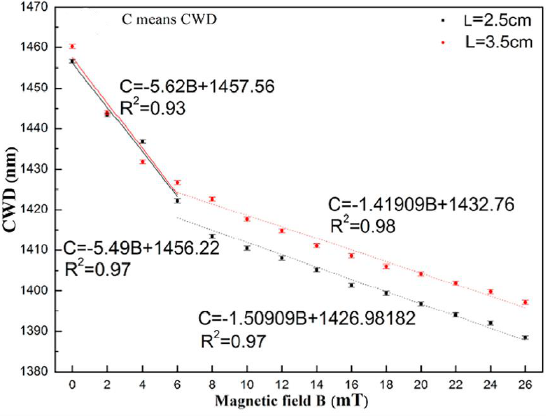
Figure 27. Dependence of the CWD with the magnetic field, for NCF with different lengths [83].